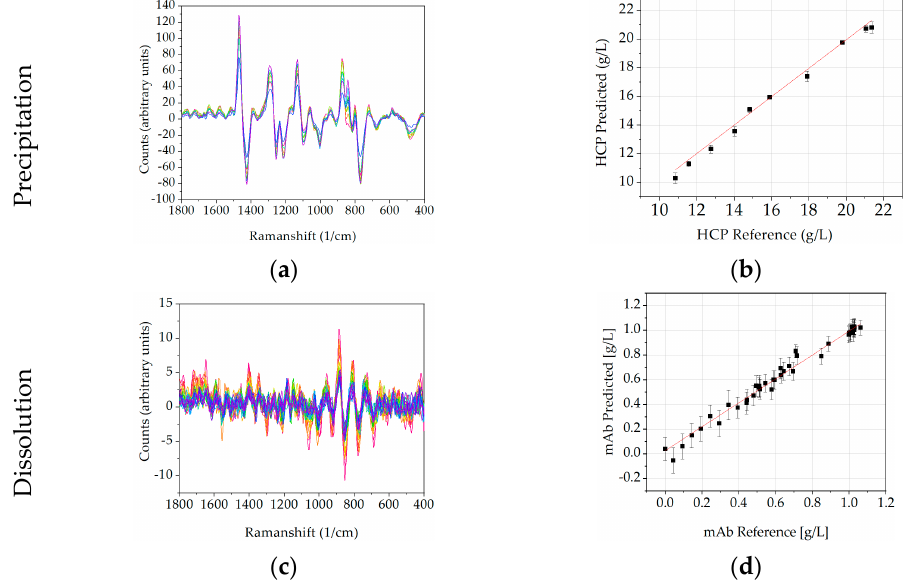
Figure 9. Raman spectral data for precipitation ( a , b ) and dissolution ( c , d ). Preprocessed spectral data are presented in ( a , c ). ( b , d ) show the PLS regression results of the prediction of the investigated CQAs. Different colors represent the spectral data for different samples and are sorted from red to blue. Sample names are equal to Figure 6. Spectral data ( c , d ) have been previously published